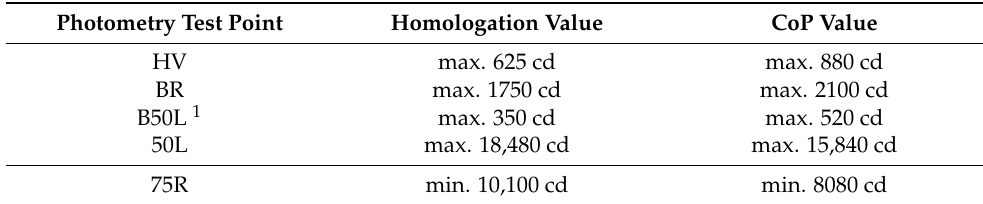
Table 1. Homologation and Conformity of Production (CoP) photometry requirements in candelas for several photometry test points.